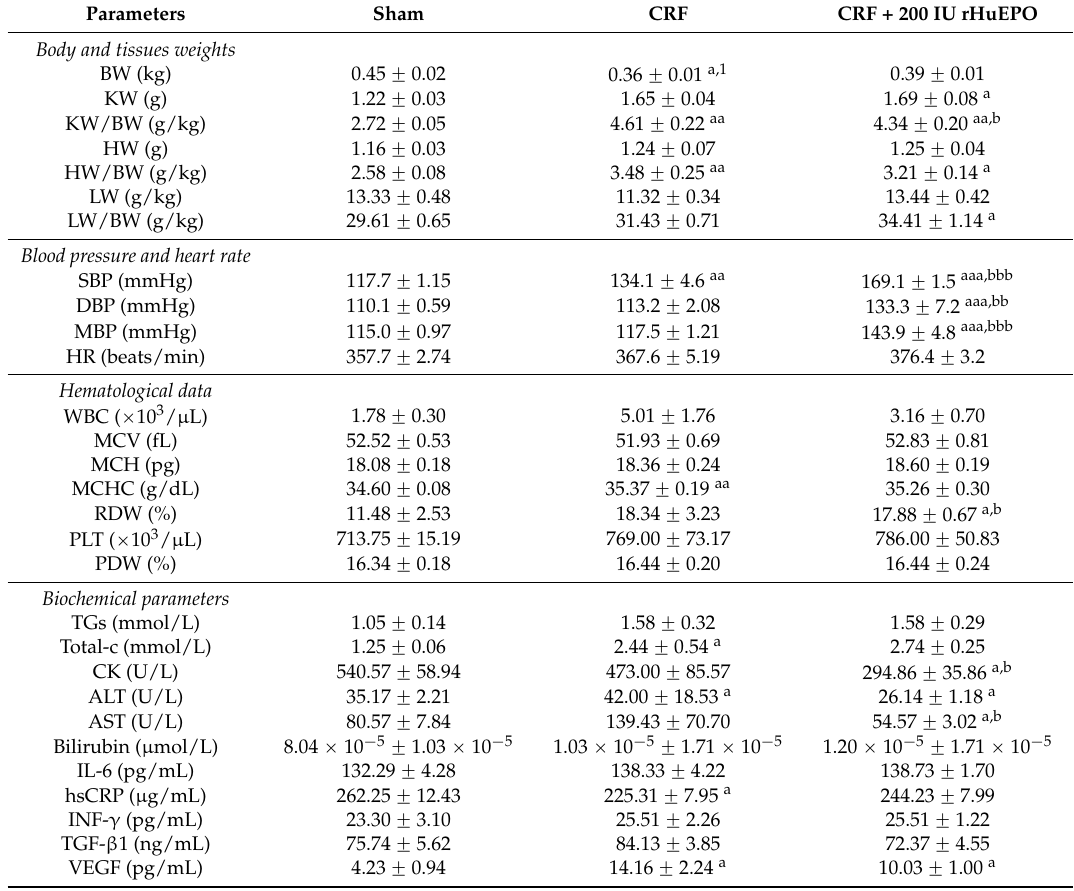
Table 1. Body and tissue weights, blood pressure and heart rate, hematological and biochemical data, at the end of